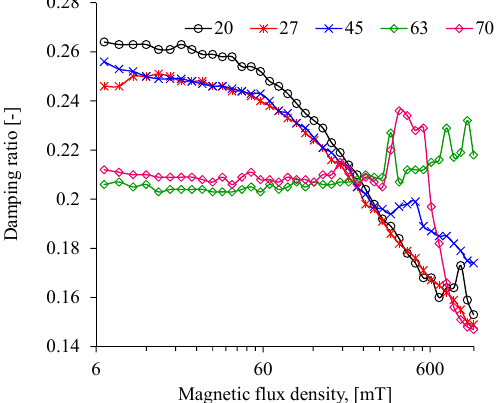
Figure 18. Influence of the magnetic flux density on the MRE damping ratio. There is a difference in the behavior of the MRE samples: for those with low CIP content (20, 27, and 45 wt %), the damping ratio values tend to decrease while for those with high CIP content (63 and 67 wt %), the damping ratio have almost a constant value up to a magnetic flux density of 311 mT.